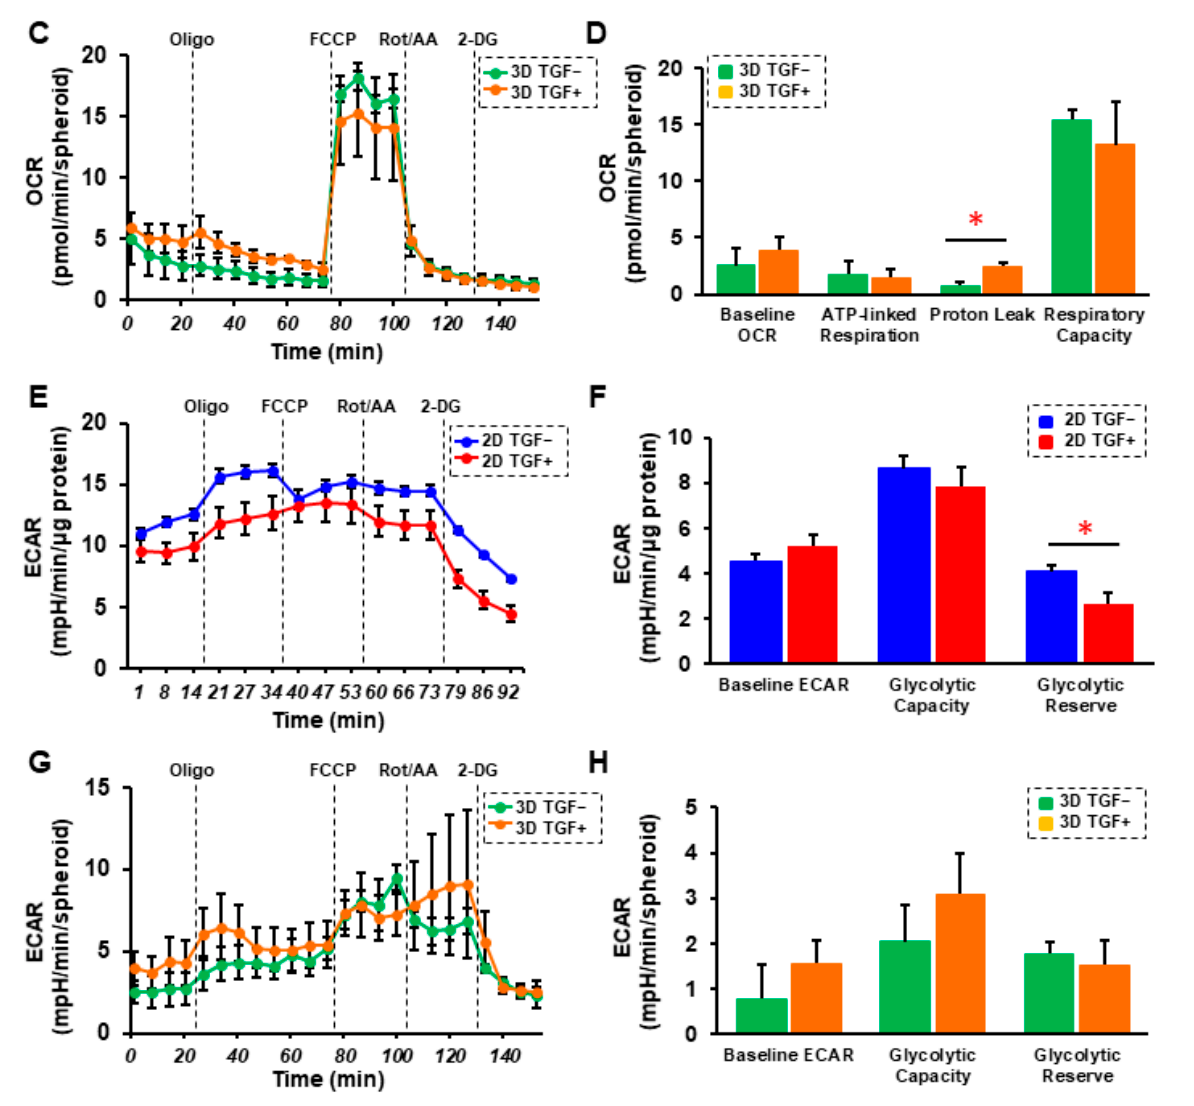
Figure 7. Effects of TGF- β 2 on the cellular metabolic phenotype of the 2D and 3D cultured HRPE cells. Two-dimensional and 3D cultured HRPE cells at Day 6 prepared under normoxia conditions were treated without (control) and with a 5 ng/mL solution of TGF- β 2 (TGF), and each sample was subjected to a real-time metabolic function analysis using a Seahorse XFe96 Bioanalyzer. ( A ) Mea- surements of oxygen consumption rate (OCR) in 2D HRPE cells without and with TGF treatment. ( B ) Baseline OCR, ATP-linked respiration, proton leak, and respiratory capacity in 2D HRPE cells. ( C ) Measurements of oxygen consumption rate (OCR) in 3D HRPE spheroids without and with TGF. ( D ) Baseline OCR, ATP-linked respiration, proton leak, and respiratory capacity in 3D HRPE spheroids. ( E ) Measurements of extracellular acidification rate (ECAR) in 2D HRPE cells without and with TGF. ( F ) Baseline ECAR, glycolytic capacity, glycolytic reserve in 2D HRPE cells. ( G ) Mea- surements of extracellular acidification rate (ECAR) in 3D HRPE spheroids without or with TGF. ( H ) Baseline ECAR, glycolytic capacity, glycolytic Reserve in 3D HRPE spheroids. Oligo = oligomycin, Rot/AA = rotenone/antimycin A, 2-DG = 2-deoxyglucose. Fresh preparations were used in all exper- iments (2D; n = 5, 3D; n = 3). Data are presented as the mean ± the standard error of the mean (SEM). * p < 0.05 control vs. TGF (Student’s t